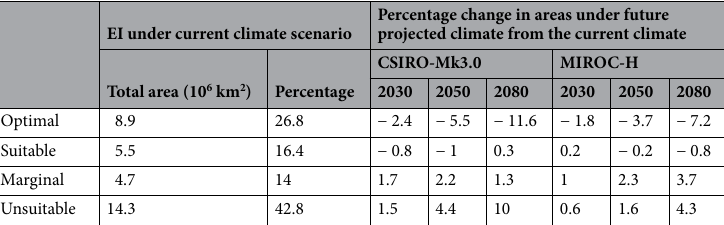
Table 2. Areas subject to projected eco-climate suitability for FAW ( Spodoptera frugiperda ) persistence under current and future projected climates, considering irrigation scenario II. The percentage values for future projected climate are the percentage change in these areas under future projected climate from the current climate.